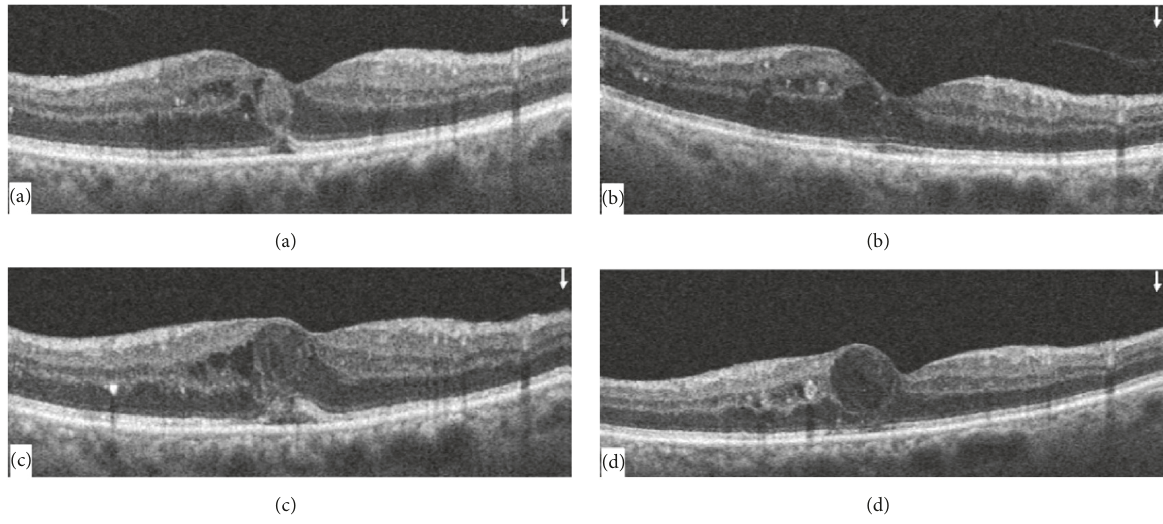
Figure 2: Structural OCT of the left macula. (a) At presentation, there were multiple intraretinal cystic spaces with mild subfoveal neurosensorydetachmentanddiffuseretinalthickening.(b)Following3monthlyintravitrealbevacizumabinjections,therewasimprovement of the retinal edema and neurosensory detachment. (c) Follow-up 4 months following the last injection showed increased intraretinal cystic spaces and retinal thickness with recurrence of neurosensory detachment. (d) Following another 3 intravitreal injections, there was improvement of the neurosensory detachment and retinal thickness.